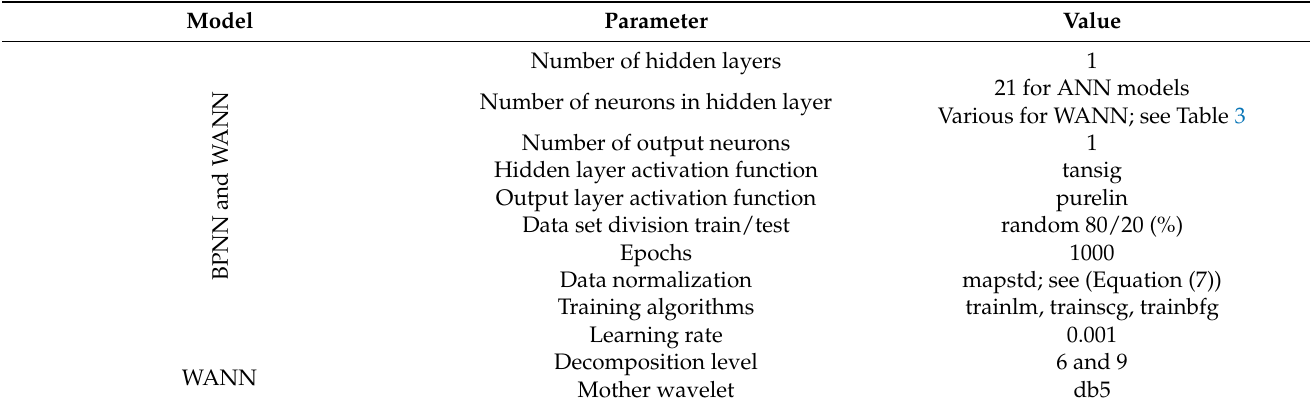
Table 4. Parameters of proposed feedforward neural networks.